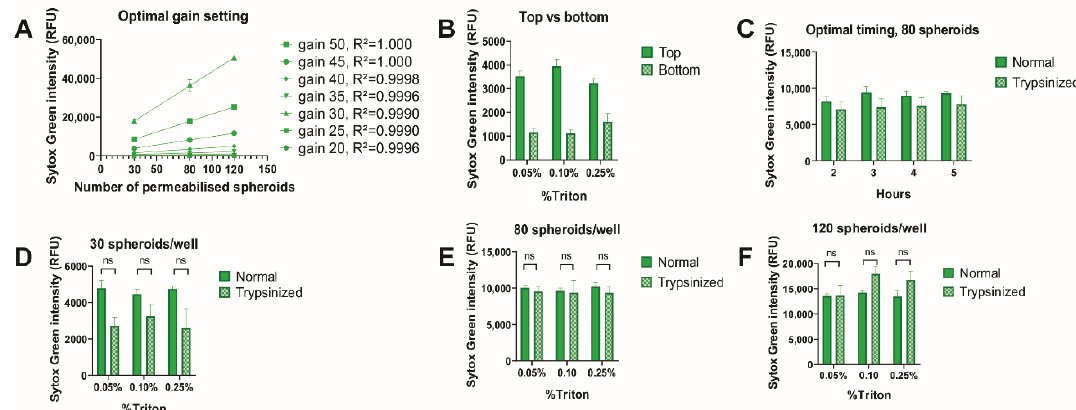
Figure 3. Triton X-100 e ffi ciently permeabilizes spheroids. L929 spheroids were stained with 3.3 µ M of Sytox Green and permeabilised with Triton X-100 in di ff erent concentrations (0.05%, 0.10% and 0.25%). Sytox Green intensity was measured using the Tecan Spark microplate reader. Either top or bottom measurement was used, and intensity was measured at di ff erent timepoints. ( A ) Optimal gain setting. The highest linearity is found at gain 45 and 50. ( B ) Comparison of top and bottom measurement. The most intense signal of Sytox Green with the lowest variation is found in top measurement. ( C ) Optimal timing for measurement. No di ff erences were observed at the di ff erent timepoints. ( D – F ) Comparison of normal and trypsinized spheroids at di ff erent cell densities and with di ff erent Triton X-100 concentration. No significant di ff erences in Sytox Green intensity were observed between normal and trypsinized. Furthermore, no significant di ff erences were found between di ff erent Triton X-100 concentrations. Data are averages from three independent experiments ( n = 3), each measured in triplicate; error bars = SEM. * p < 0.05, ** p < 0.01, *** p < 0.001, ns = not significant. RFU = relative fluorescent unit.